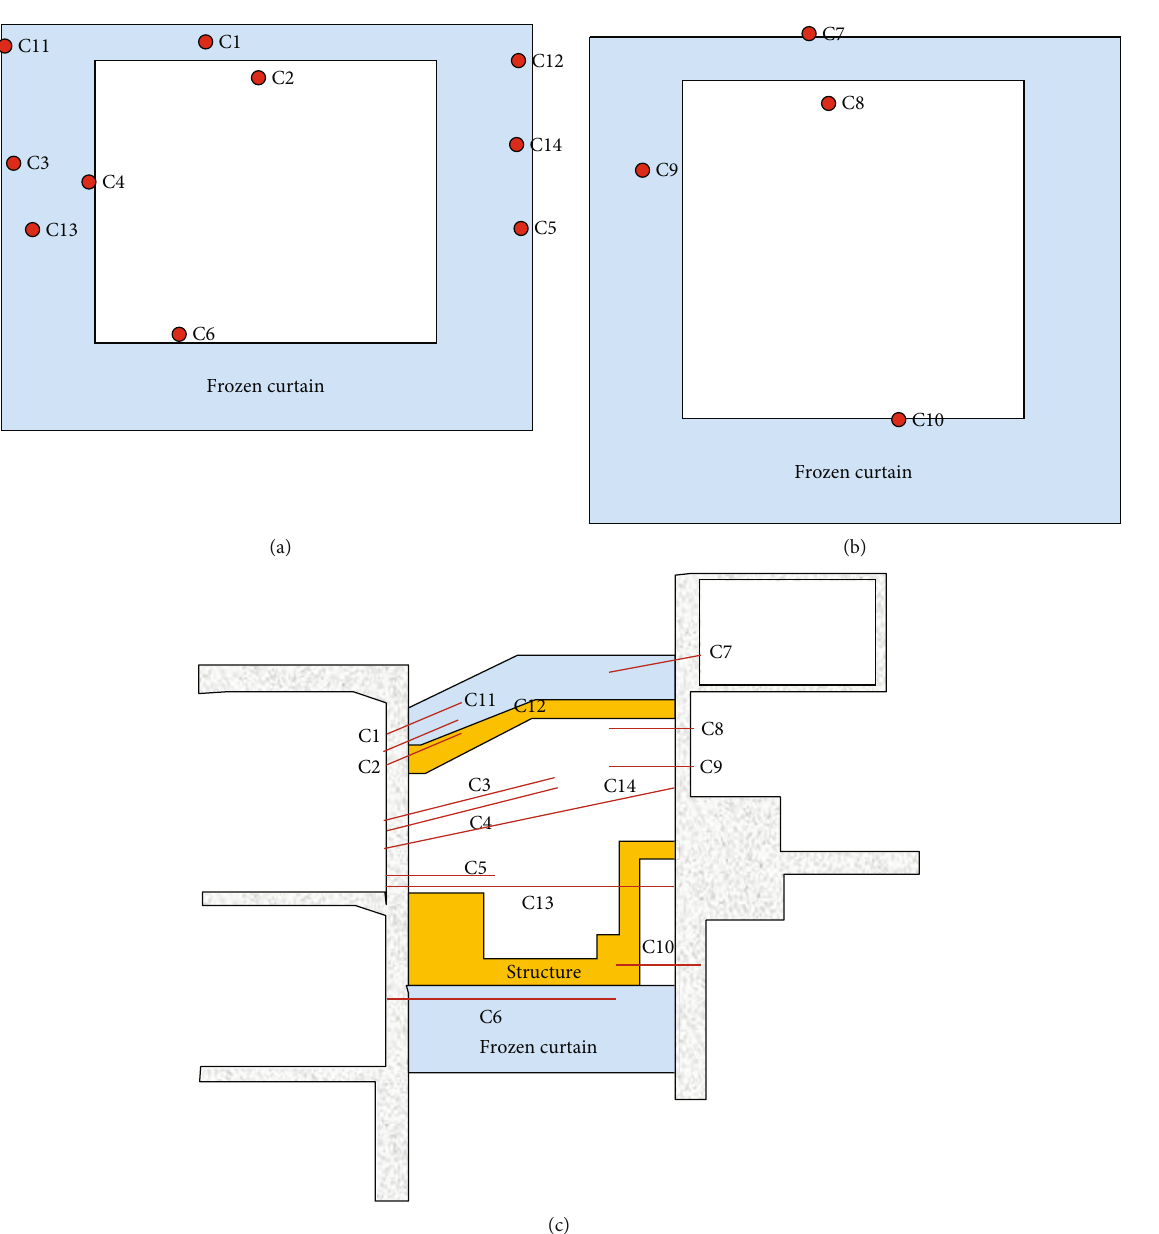
Figure 3: (a) Temperature measuring pipes in main working face; (b) temperature measuring pipes in auxiliary working face; (c) temperature measuring pipes in lateral